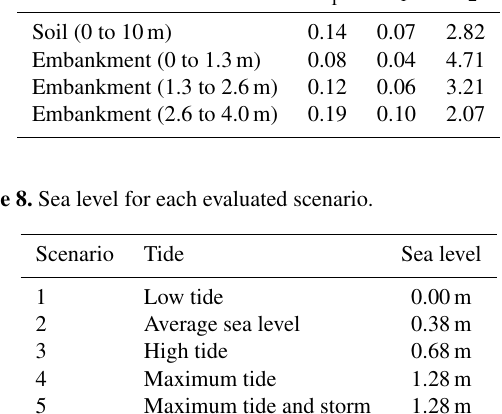
Table 7. Coefficients used for the Finn–Byrne model. Element